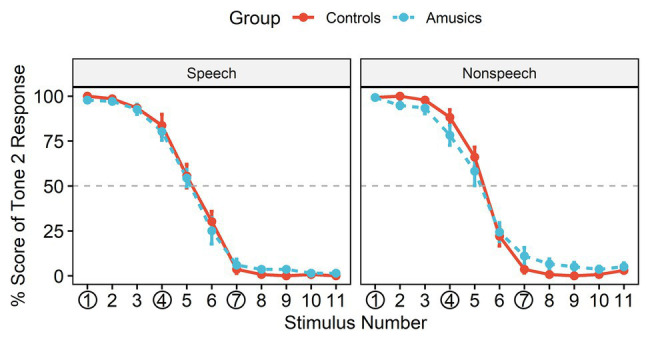
The identification curves of Tone 2 responses in the two groups, where the red solid lines represent responses in the control group and the blue dashed lines represent responses in the amusic group. Error bars: +/−1 standard error.